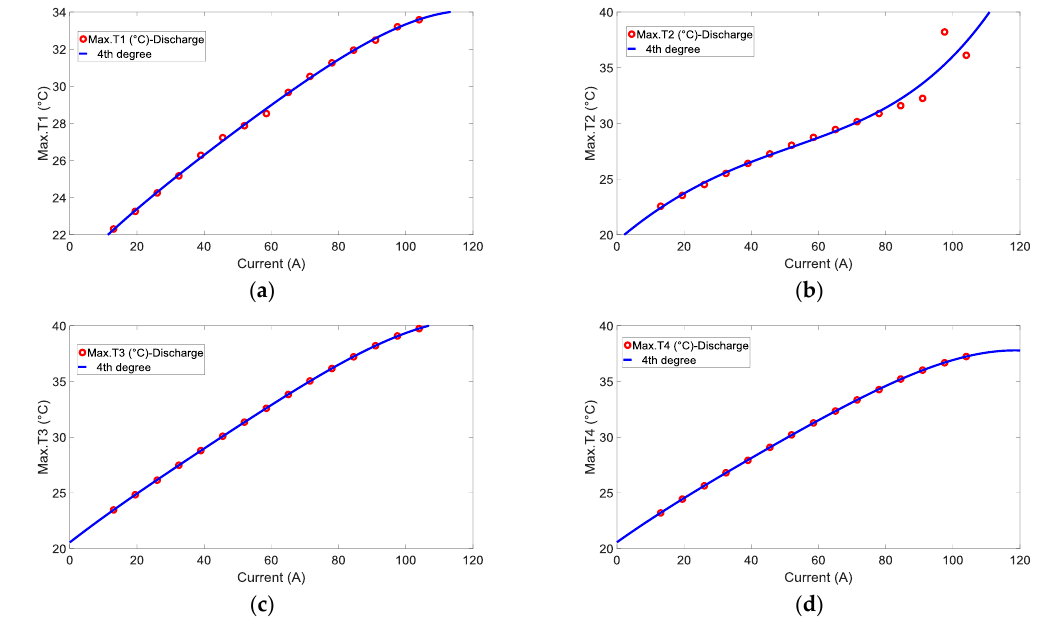
Figure 14. Maximum temperatures evolution and their curve fitting during discharge. ( a ) Max. T 1 -Discharge; ( b ) Max. T 2 -Discharge; ( c ) Max. T 3 -Discharge; ( d ) Max. T 4 -Discharge.